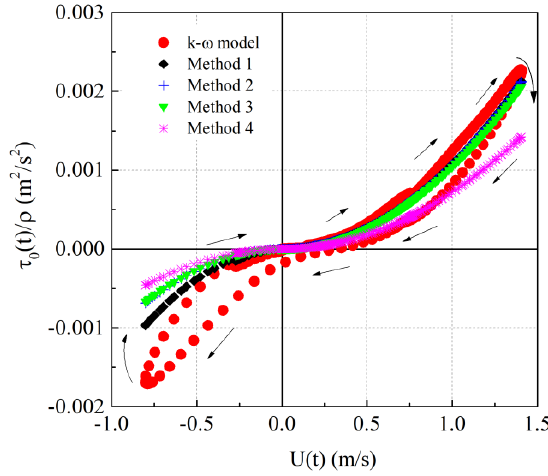
Figure 13. Relationship between 𝜏 0 (𝑡)/𝜌 and 𝑈(𝑡) .